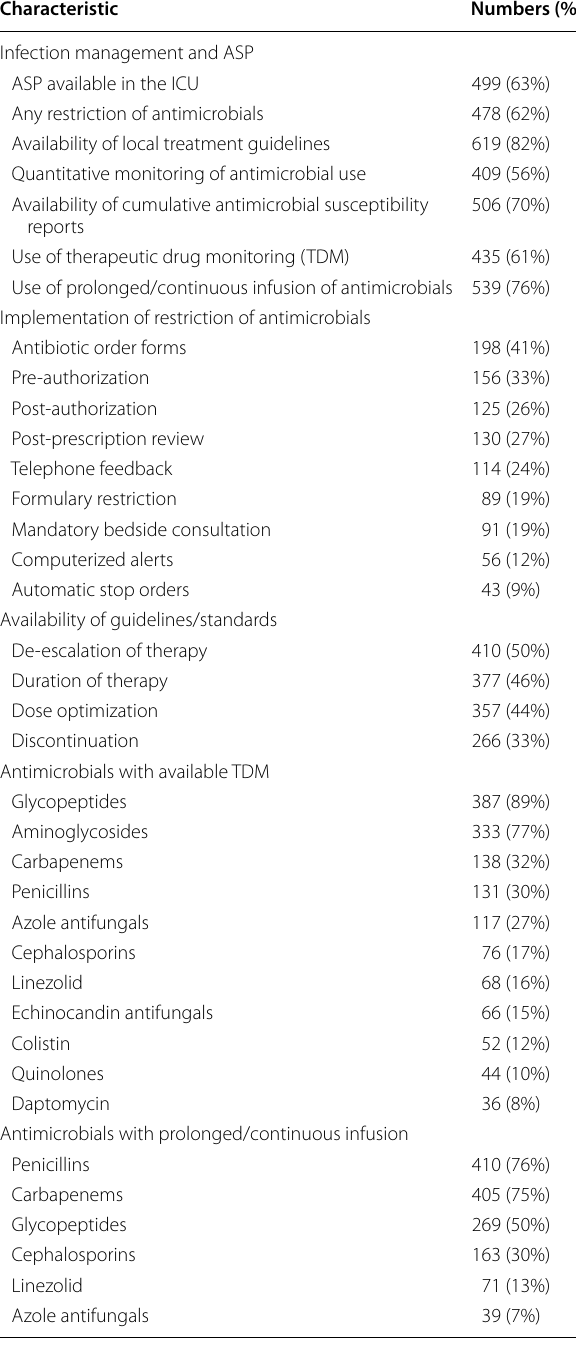
Table 2 Details on antimicrobial stewardship programs (ASP) and therapeutic drug monitoring